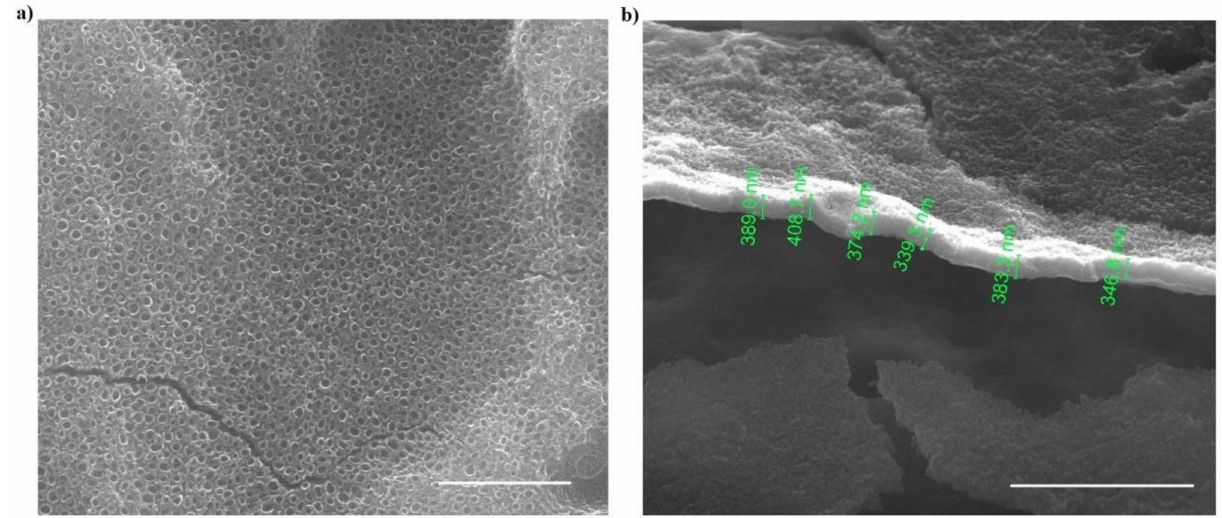
Figure 4. An example of morphology of anodic titanium oxides generated at 50 V in an electrolyte with 10 vol% of water: ( a ) top view, and ( b ) cross-section view. The bar corresponds to ( a ) 1 µ m and ( b ) 3 µ m of real